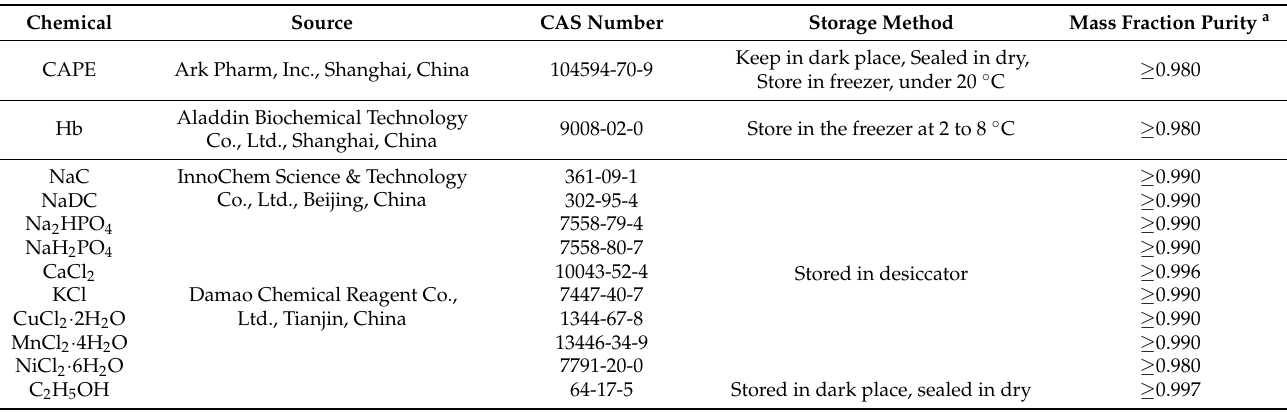
Table 6. Details of the chemicals used in the current